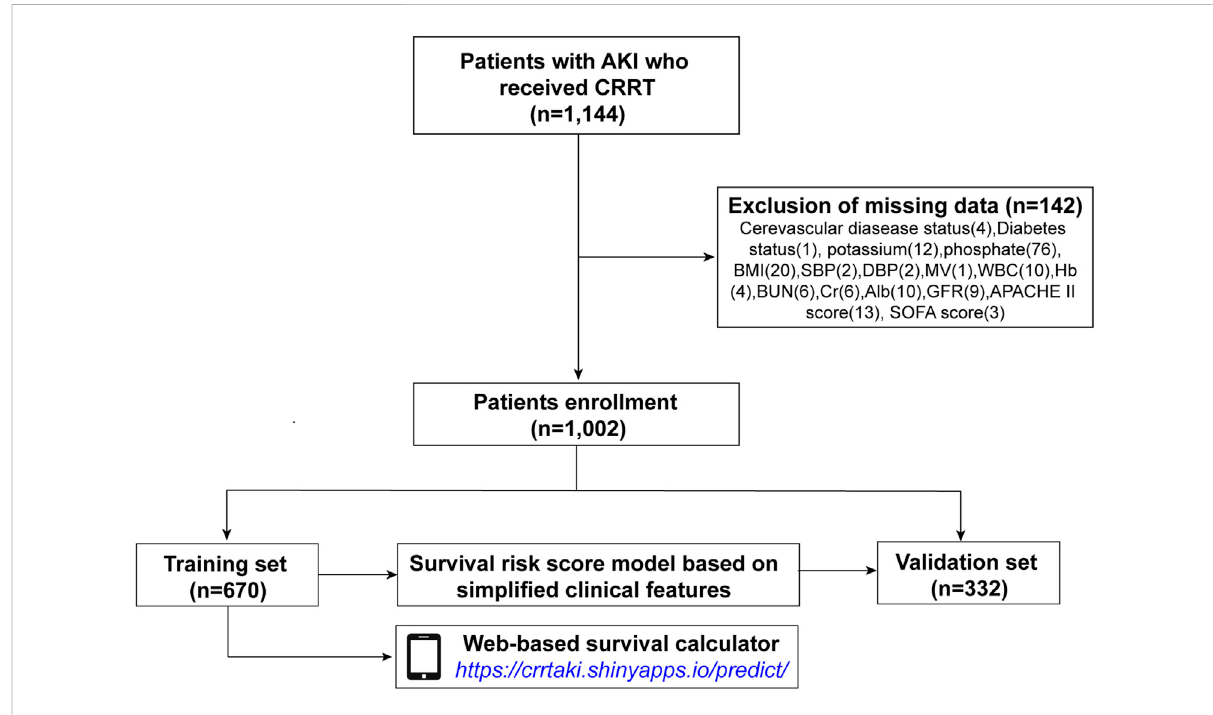
FIGURE 1 Flow chart of the training and validation